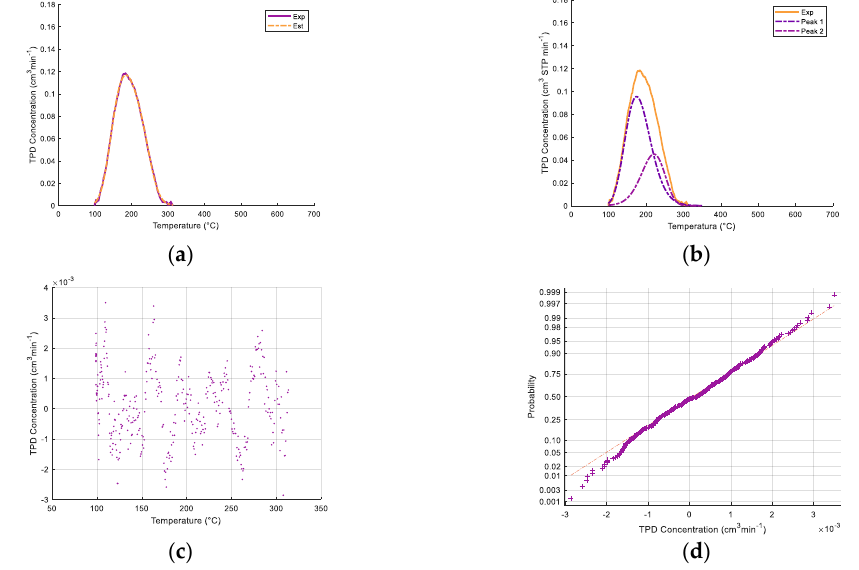
Figure A2. Deconvolution of the NH 3 -TPD curve for 10% CaO / γ -Al 2 O 3. ( a ) adjustment curve with R 2 = 0.999, ( b ) composition curves, ( c ) regression residues, ( d ) probability distribution of the adjustment curve